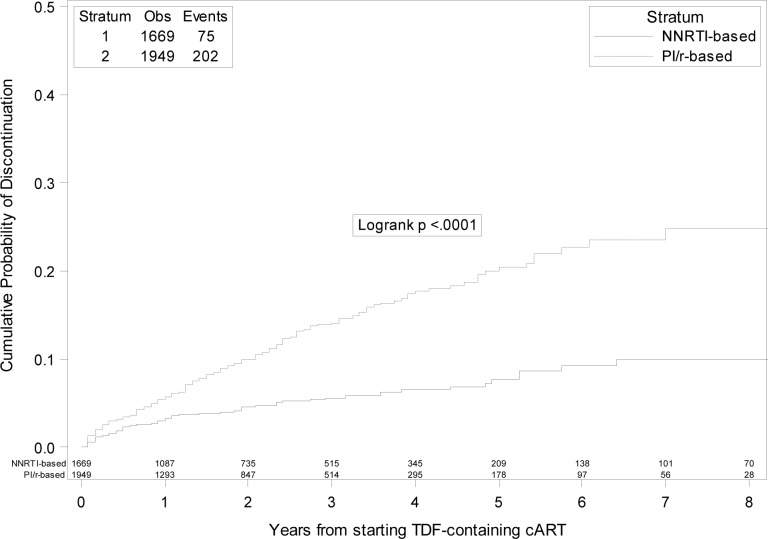
Kaplan-Meier estimates of risk of tenofovir discontinuation regardless of the reason in boosted protease inhibitors versus non-nucleoside reverse transcriptase inhibitors groups.